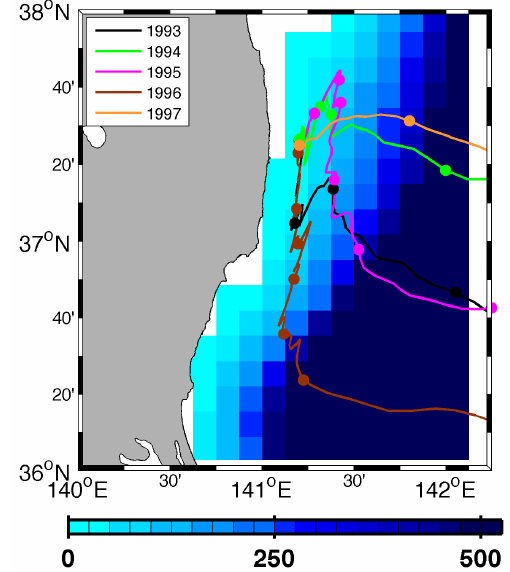
Fig. 9. Movement of the center of mass of simulated 137 Cs patches. The line colors denote respective nominal years indicated in the leg- end. The dots on the respective tracks are separated by one fortnight. The cyan-to-blue color shading refers to the bathymetry interpo- lated onto the model-grid in